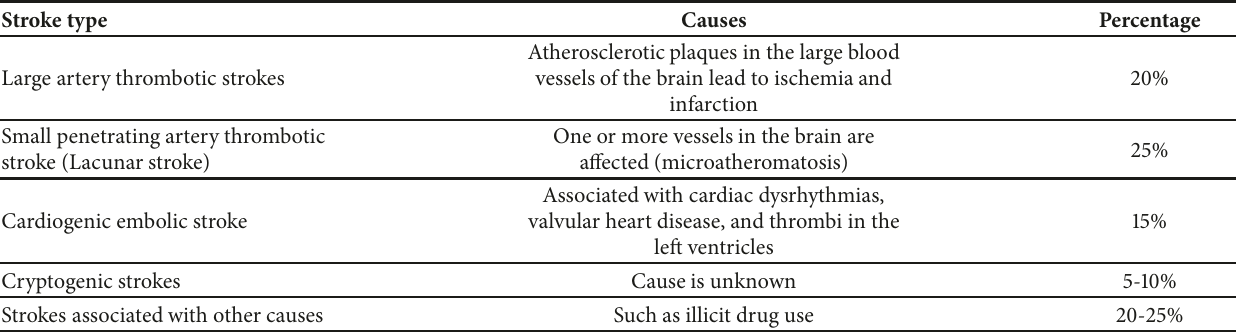
Table 1: Types of ischaemic stroke based on the TOAST